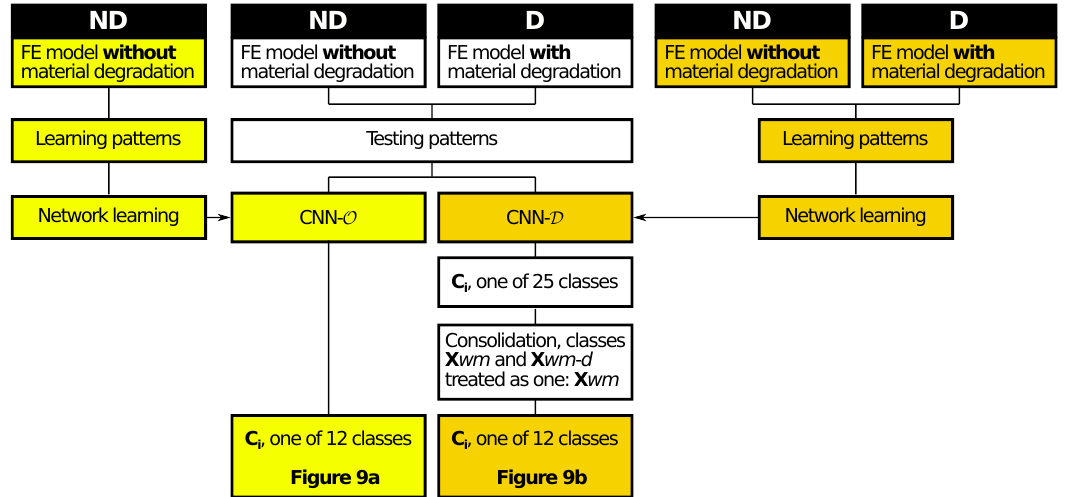
Figure 10. An algorithm applied to identify mode shapes (information about material model degradation neglected); for the results, see Figure